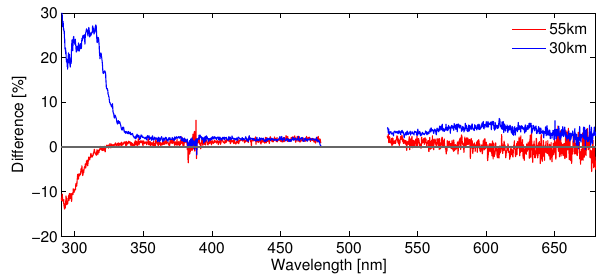
Fig. 8. Median relative difference of the 14 OSIRIS and stray light corrected GOMOS radiance ratios at 30km (blue) and 55km (red). Radiances were normalized with the 47km spectrum.